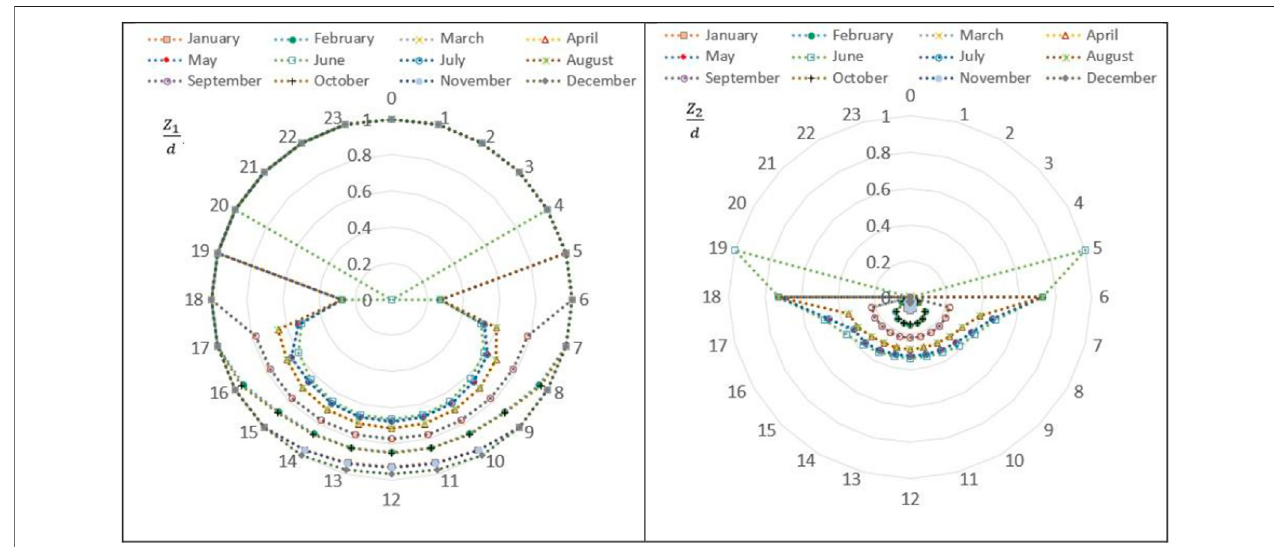
and Z 2 for the 21st of every month for given design parameters ∅ (cid:2) 32 . 815 ° N, ψ (cid:2) 0, β (cid:2) 20 ° , d d